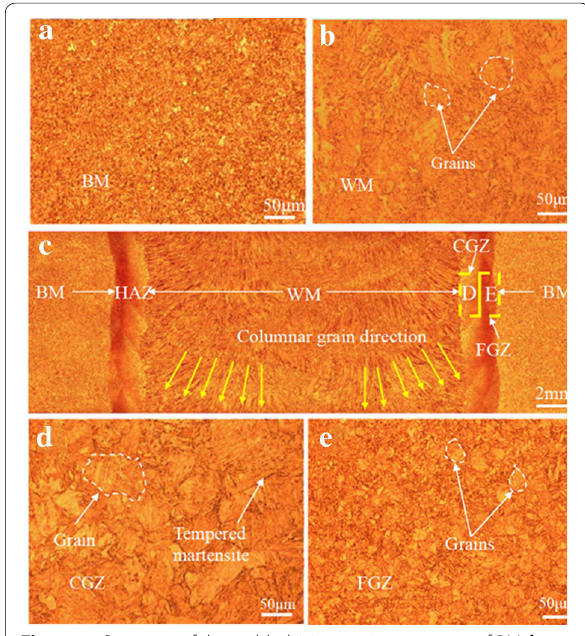
Figure 5 Structure of the welded joint: a microstructure of BM, b macrostructure of WM, c the overall macrostructure of the whole welded joint, d microstructure of course grain zone, e microstructure of fine grain zone